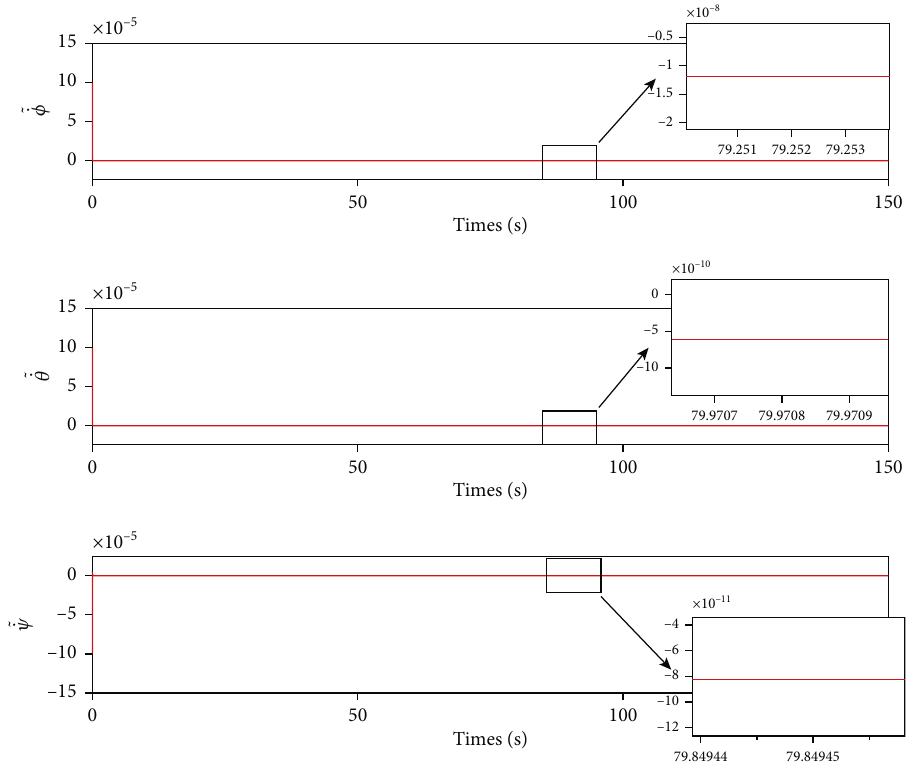
Figure 15: Observation errors of ESO in attitude subsystem.